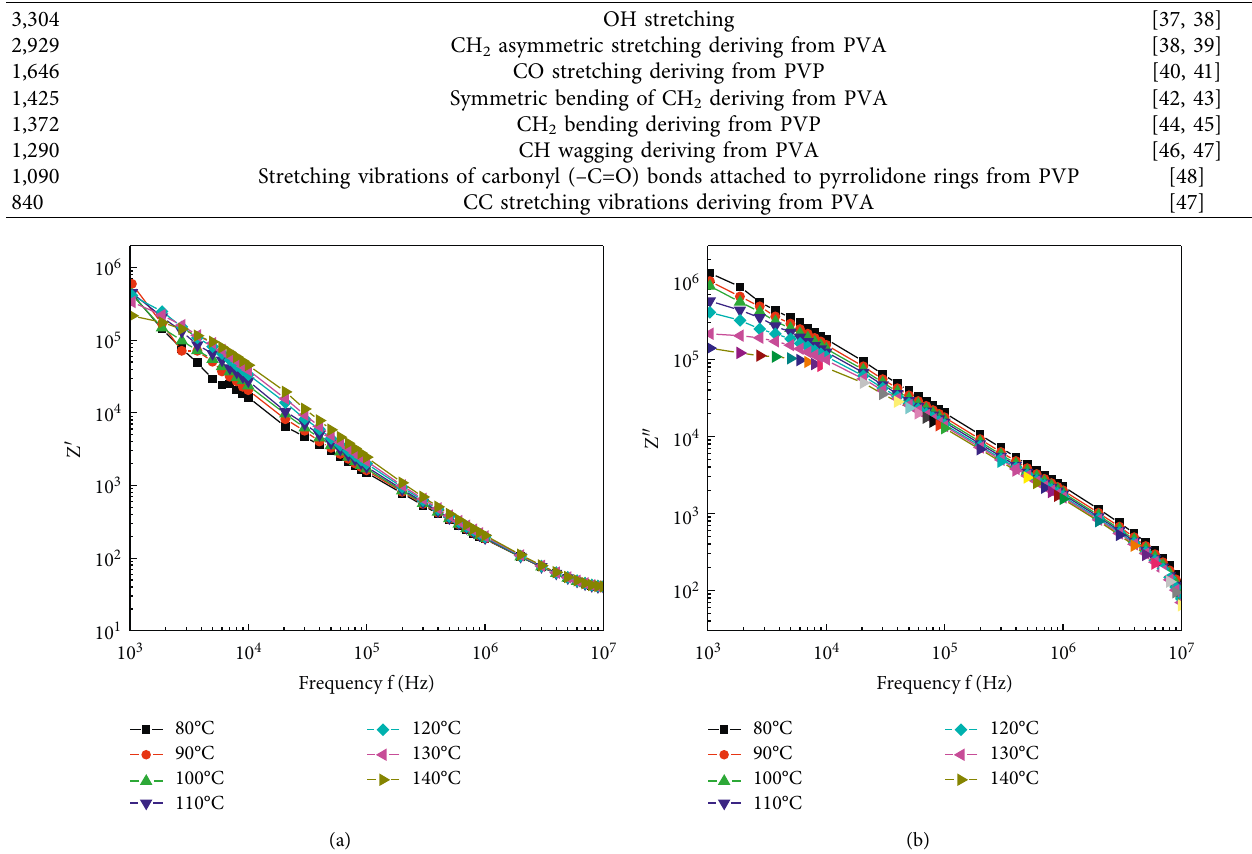
Figure 2: (a) Real part of impedance (Z ′ ) and (b) imaginary part of impedance (Z ′ ) for PVA/PVP polymer blend.